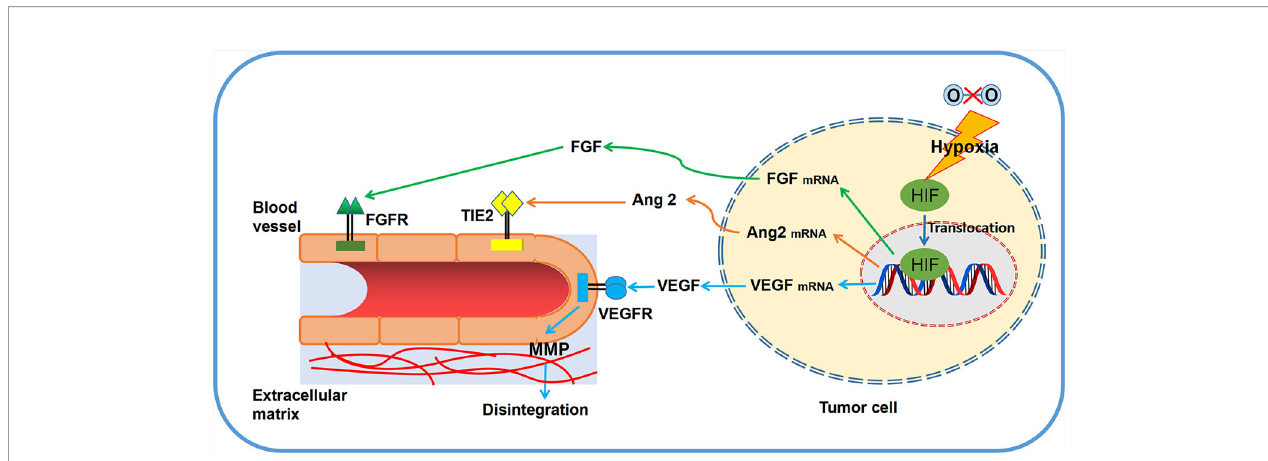
FIGURE 1 | Primary principles of angiogenesis in tumor microenvironment. Several signi fi cant regulators (VEGF, FGF, MMPs, TIE2) and related pathways are involved in tumor